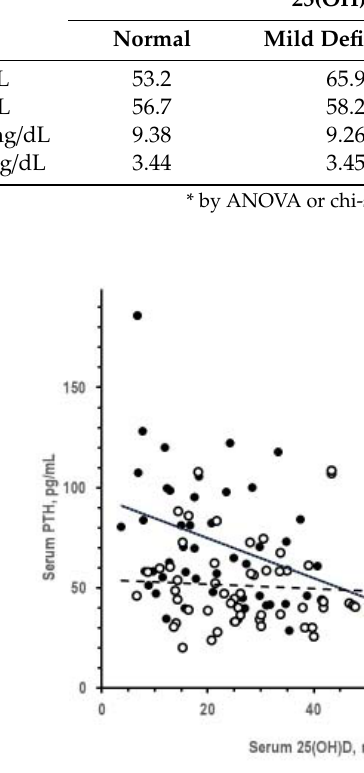
Table 3. 25(OH)D status and other lab tests: Mean. Table 3. – 25(OH)D status and other lab tests: Mean.